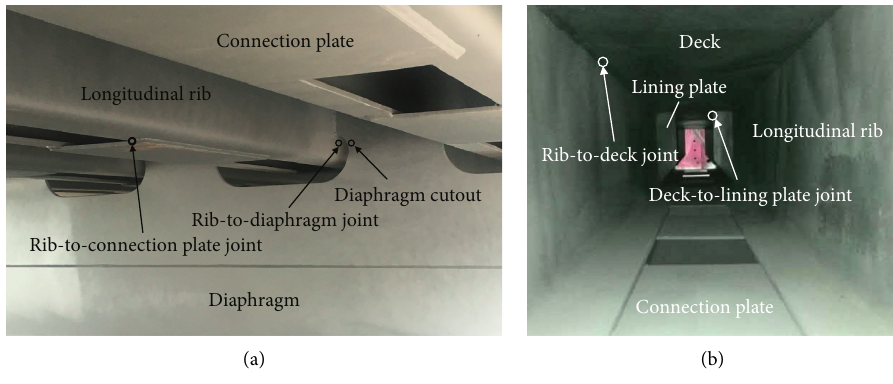
Figure 3: The location of each fatigue detail.